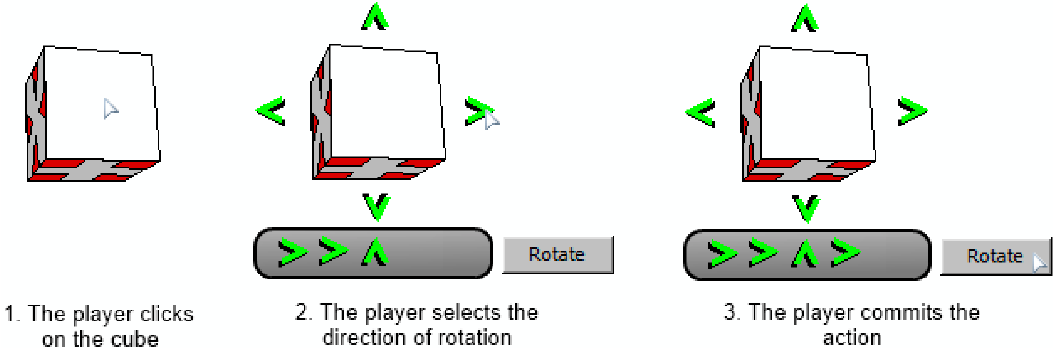
Figure 8. An example of multiple rotations of the cube with the on-demand type of activation. Figure 9. An example of multiple rotations of the cube with the on-demand type of